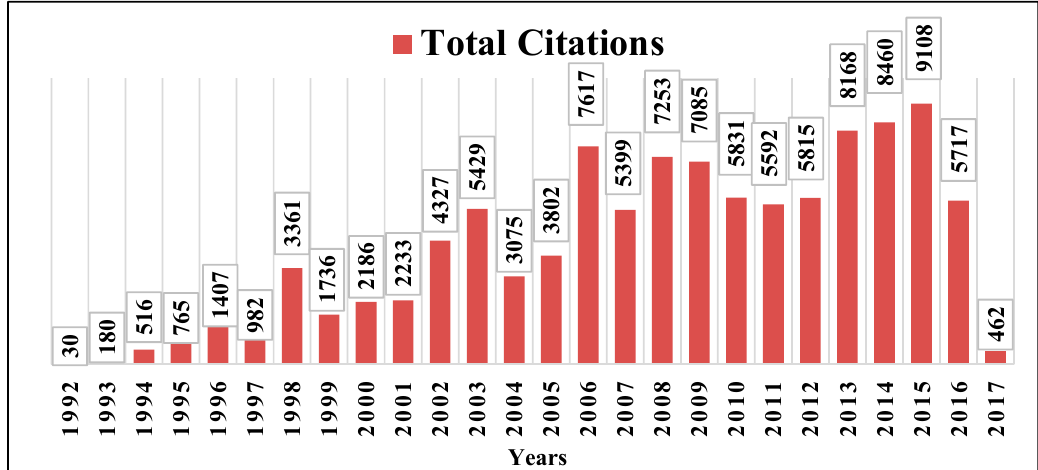
Figure 2. Citations structure of NC over the years.